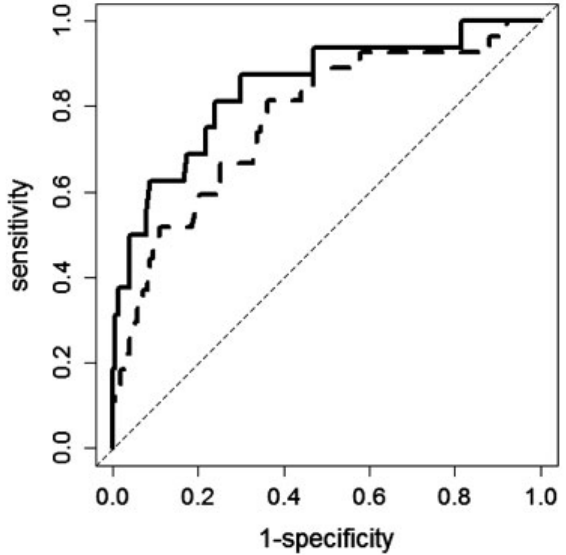
Fig. 2 ROC curves of the two predictive models without (dashed line) and with (continuous line) D-dimer, categorizedat the 75th percentile of its distribution in the cohort of PE patients (i.e., 5,000 ng/mL). The two models also contained the four ESC risk classes, age, and sex.